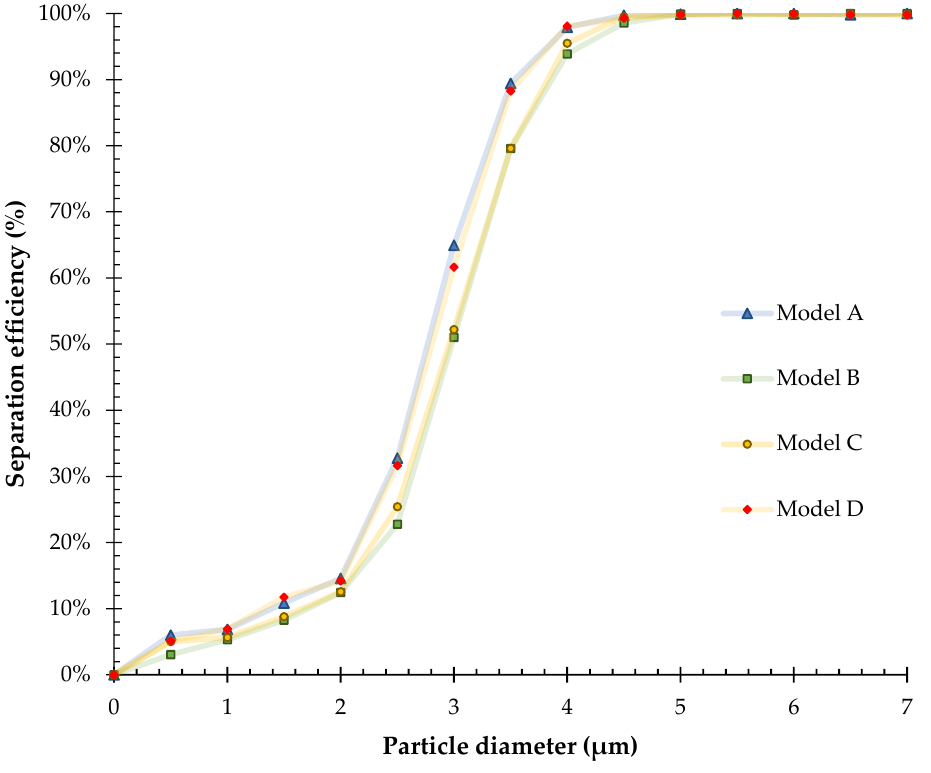
Figure 11. Grade efficiency curves of cyclone models A, B, C y D.